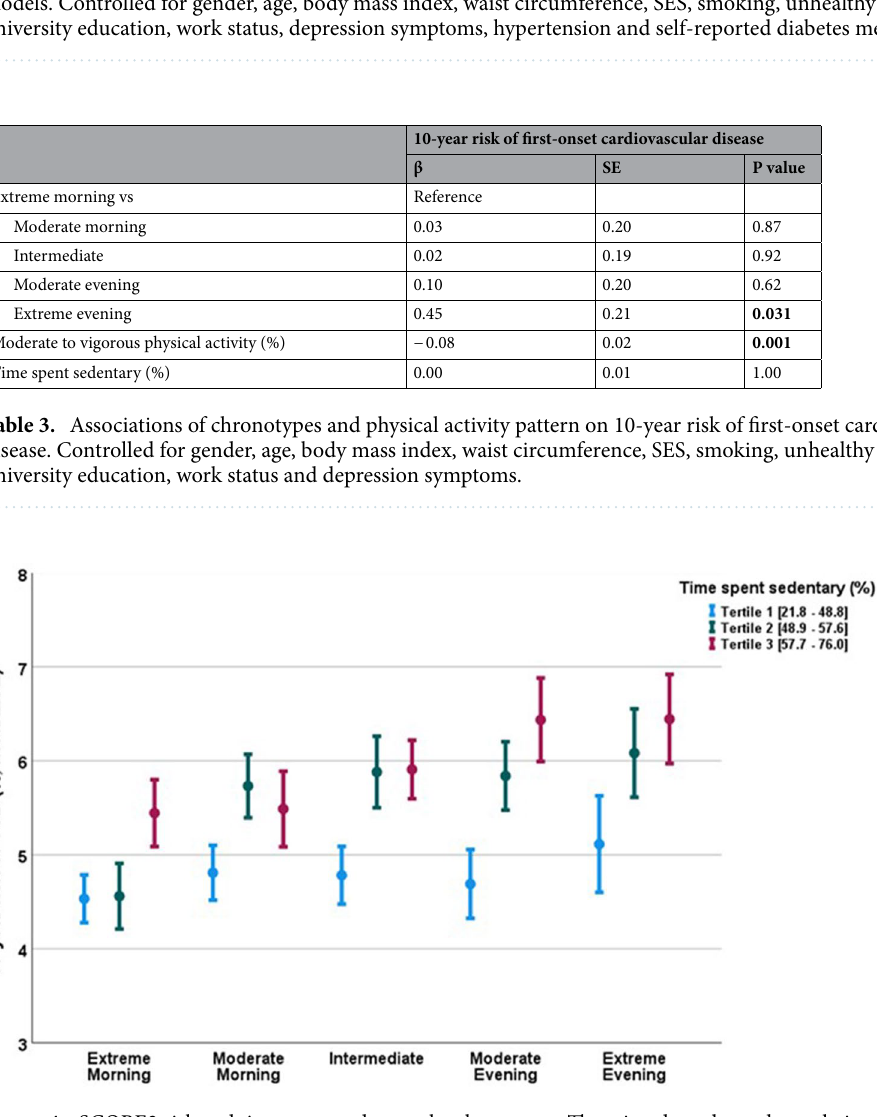
Figure 4. SCORE2 risk and time spent sedentary by chronotype. There is a dose-dependent relationship between chronotype and SCORE2 (ANOVA, p = 0.002). There is also a dose-dependent relationship between SED (represented in tertiles) and SCORE2 in the intermediate and moderate evening chronotypes (ANOVA, p = 0.034 and p = 0.013,